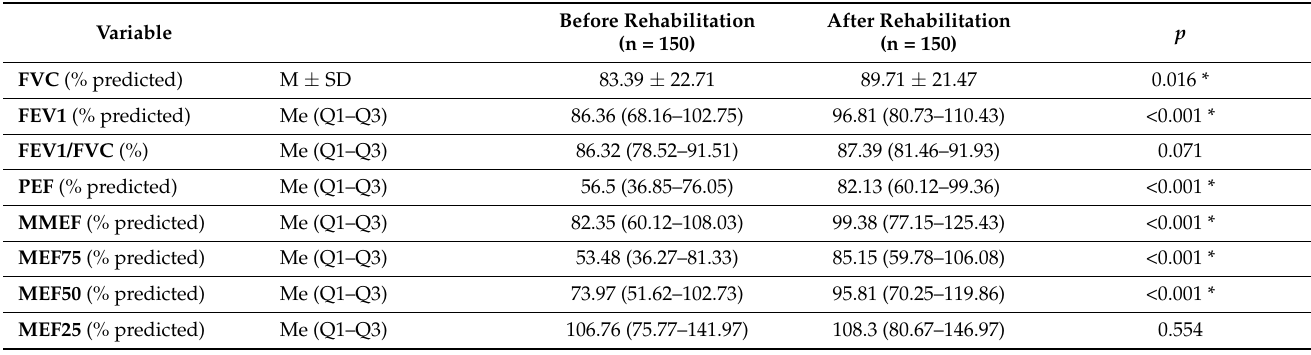
Table 3. Relationships between spirometric results before and after